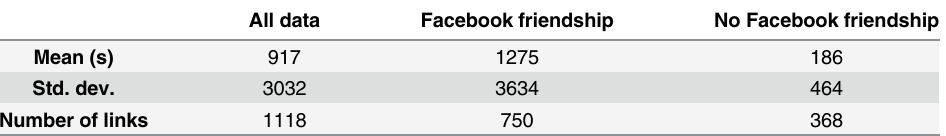
Table 7. Mean and standard deviation of the distributions of aggregate durations for different sets of links in the contact network. All data